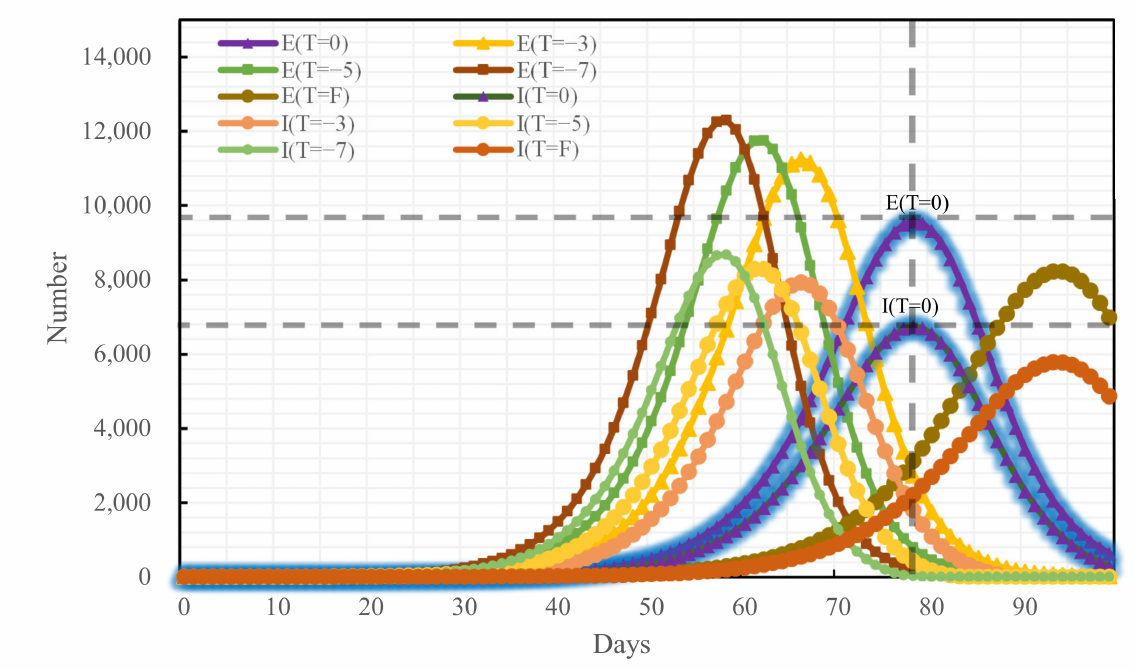
Figure 9. Epidemic trend under the home-quarantine policy promulgated at distinct time